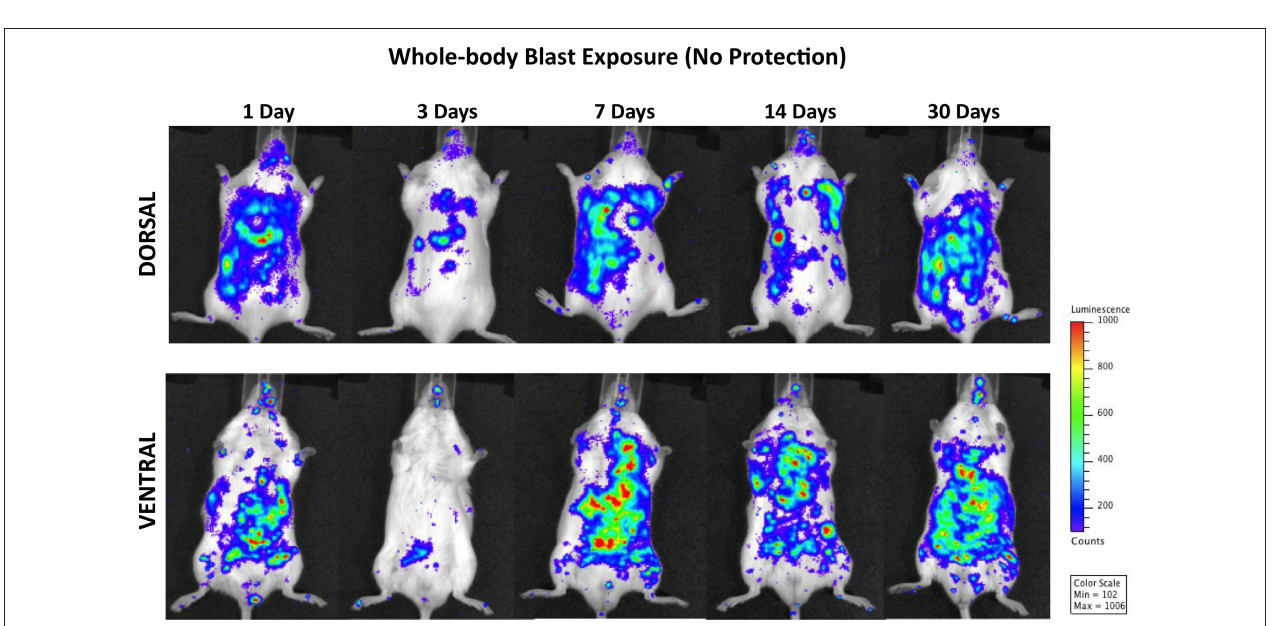
Figure 2 | experimental setting for establishing the importance of blast-head and blast–body interactive pathways in the pathobiology of BiNT. (A) whole-body blast exposure without protection; (B) head blast exposure with torso (chest and abdomen) protection; and (C) torso blast exposure with head